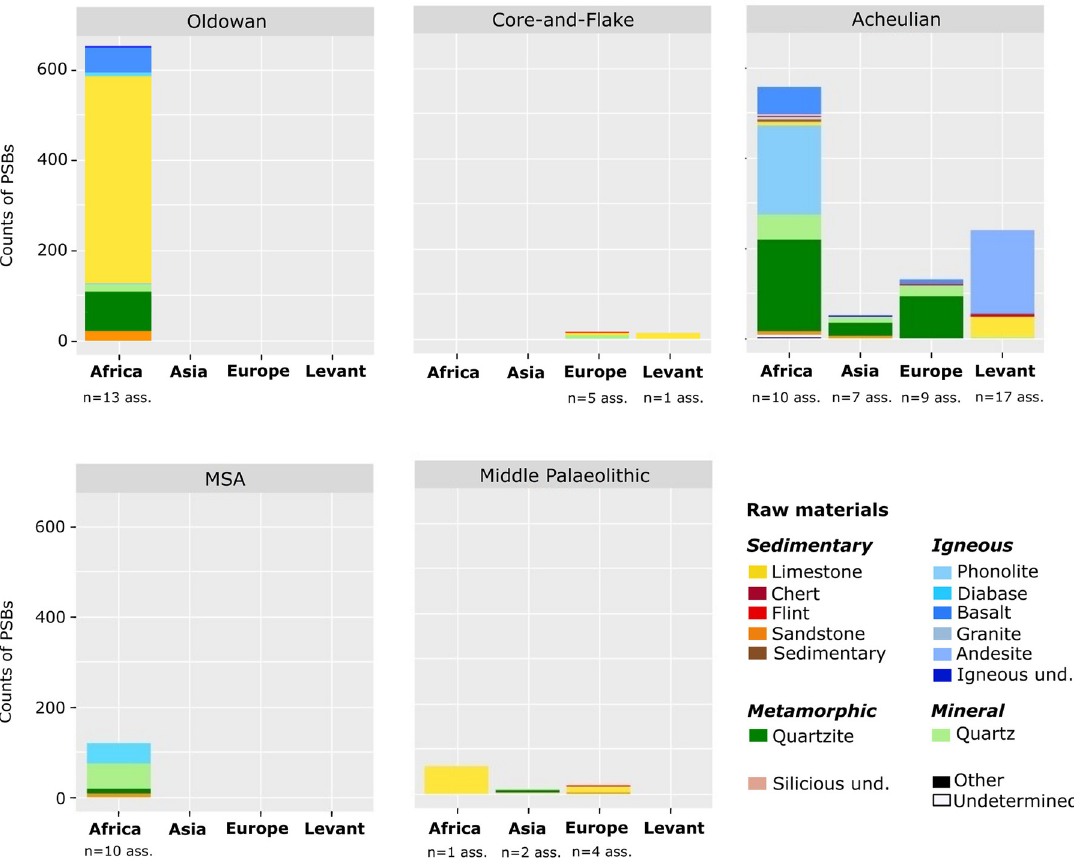
Fig 7. Counts of PSBs in each raw material per assemblage, per region and chrono-cultural attribution. For more details about counts: see Tables 3 and 4. Igneous und.: unspecified igneous rock. Siliceous und.: unspecified siliceous rocks. Sedimentary: breccia and ironstone. Ass.: